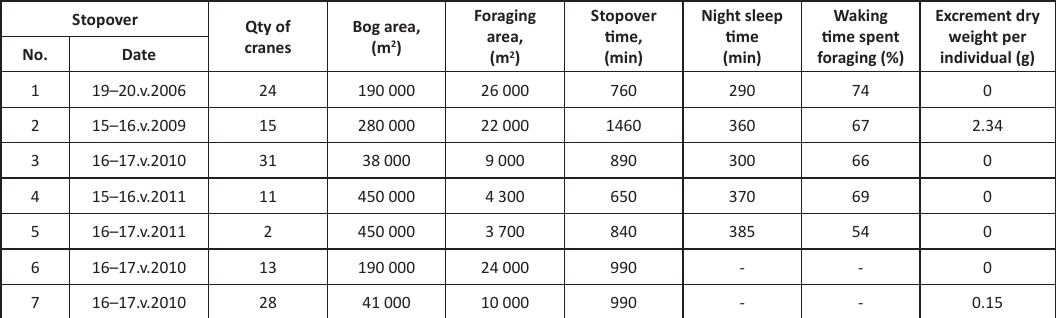
Table 2. Basic characteristics of the observed spring stopovers